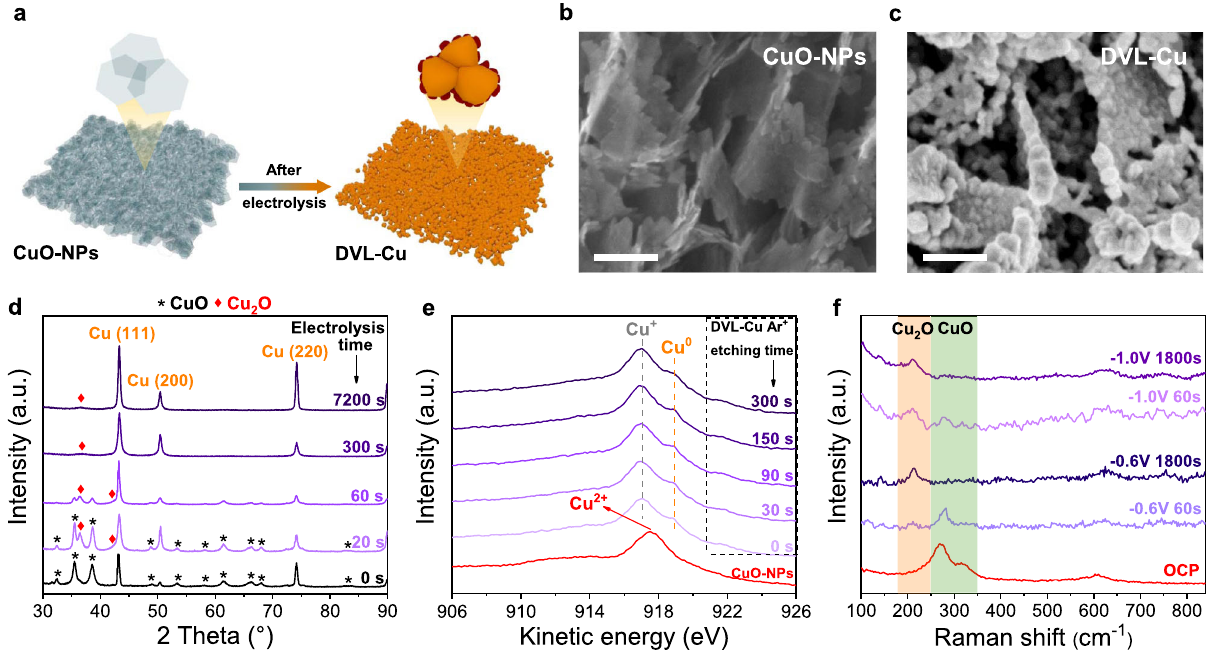
Fig. 2 Preparation and characterization of DVL-Cu. a Schematic illustration of morphology changes during the electrochemical reduction of DVL-Cu and CuO-NPs. b , c High-magni fi cation SEM images of CuO-NPs ( b ) and DVL-Cu ( c ). The scale bars are 200 nm. d GI-XRD patterns of CuO-NPs and DVL-Cu for different reduction times. e Cu LMM Auger spectra of CuO-NPs and DVL-Cu (after 1 h reduction) with respect to different Ar + etching times. f In situ Raman spectra of DVL-Cu during